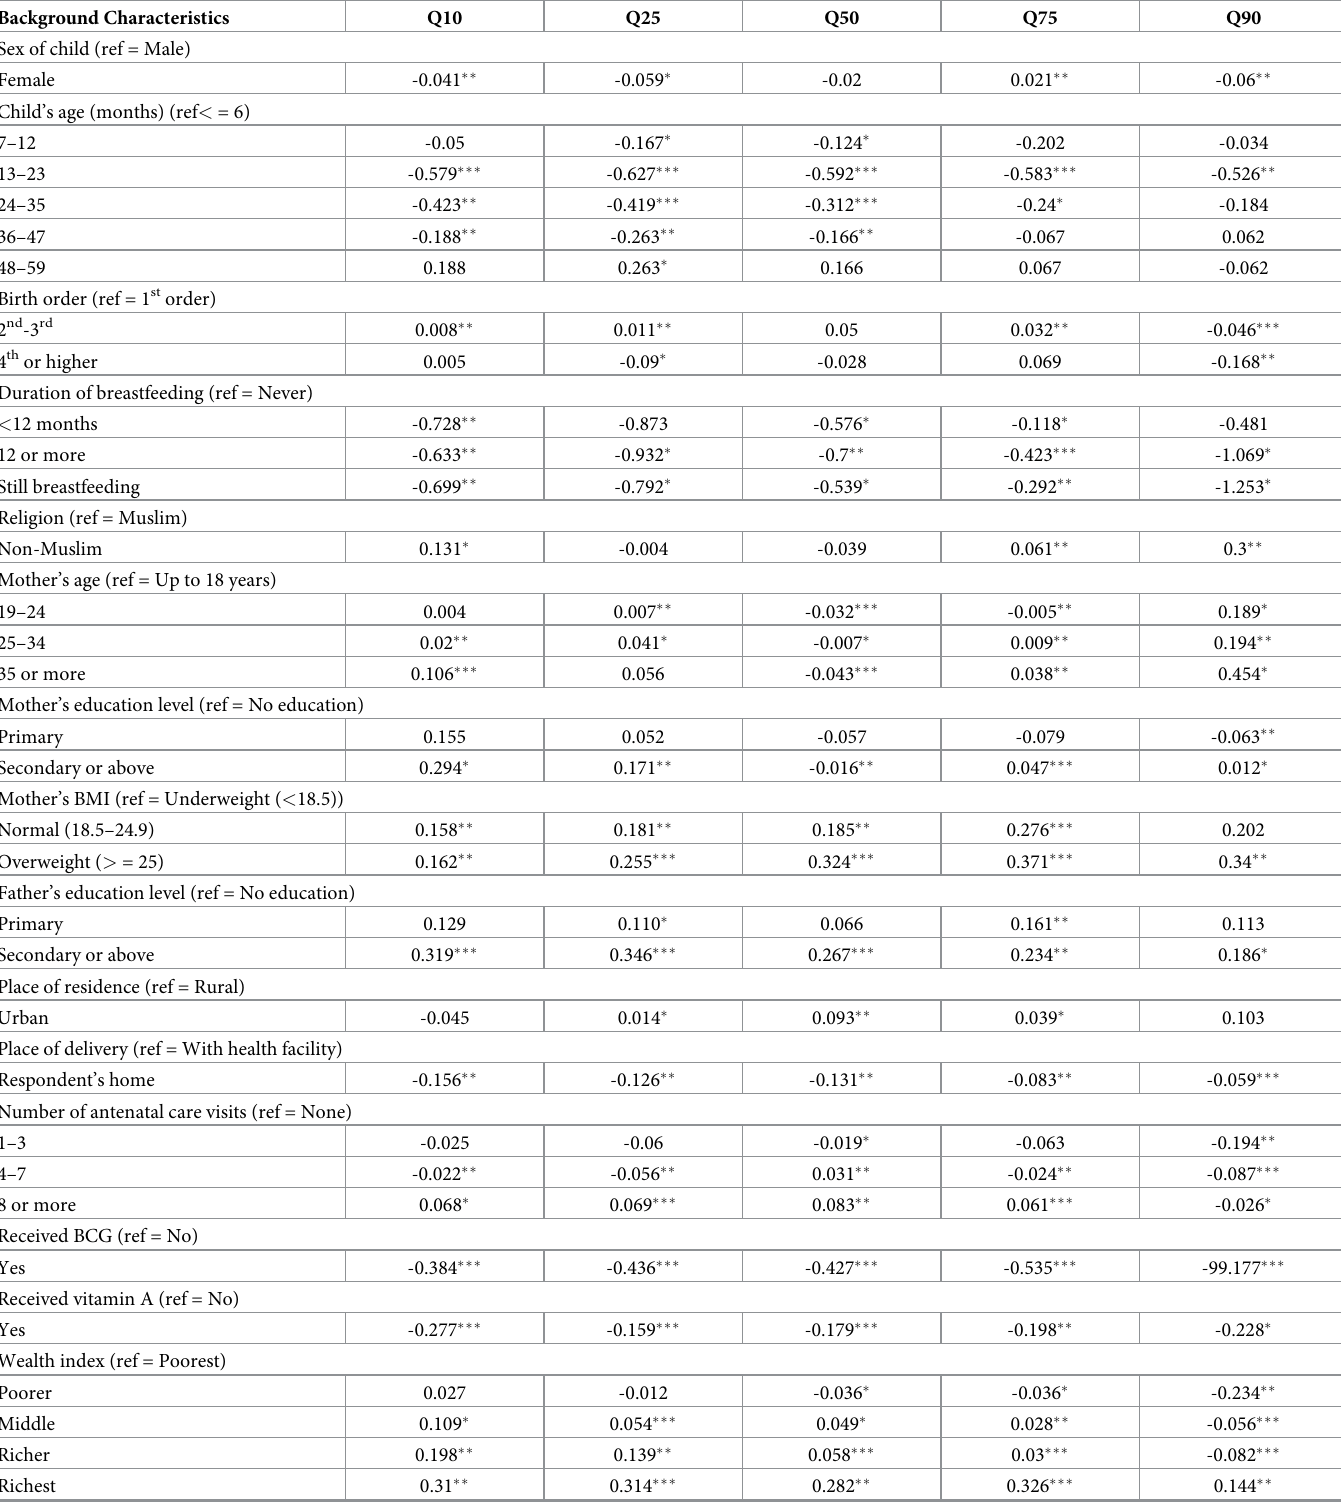
Table 2. Quantile regression modeling results of selected risk predictors for stunting (HAZ score) for under five children in Bangladesh, 2017–18. Background